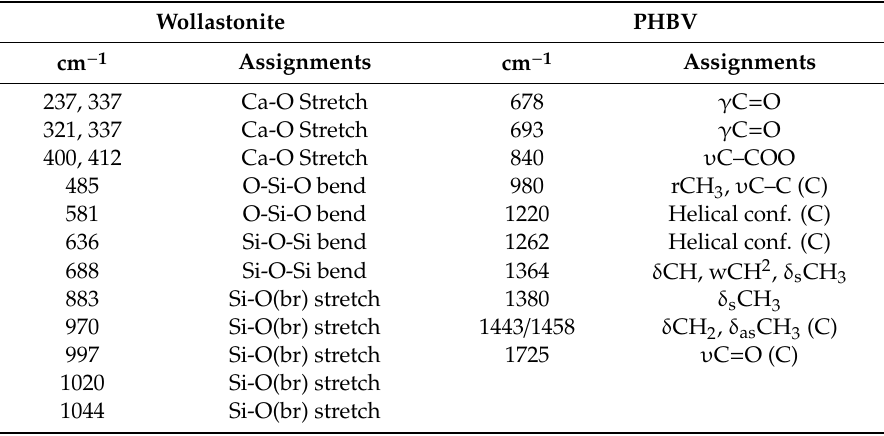
Figure 9. Results of water uptake ( a ) and kinetics fittings of PHBV ( b ), PHBV / 5%WOL-S ( c ) and PHBV / 10%WOL-S ( d ). Table 1. The Raman assignments modes of WOL and